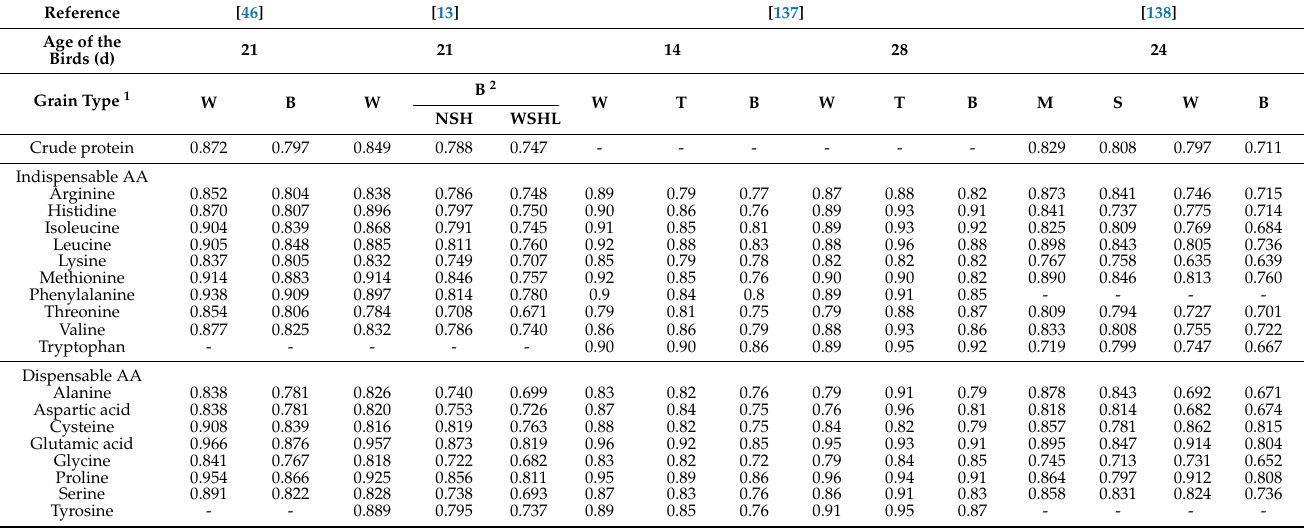
Table 7. Comparison of standardised ileal digestibility of amino acids (AA) in different cereal